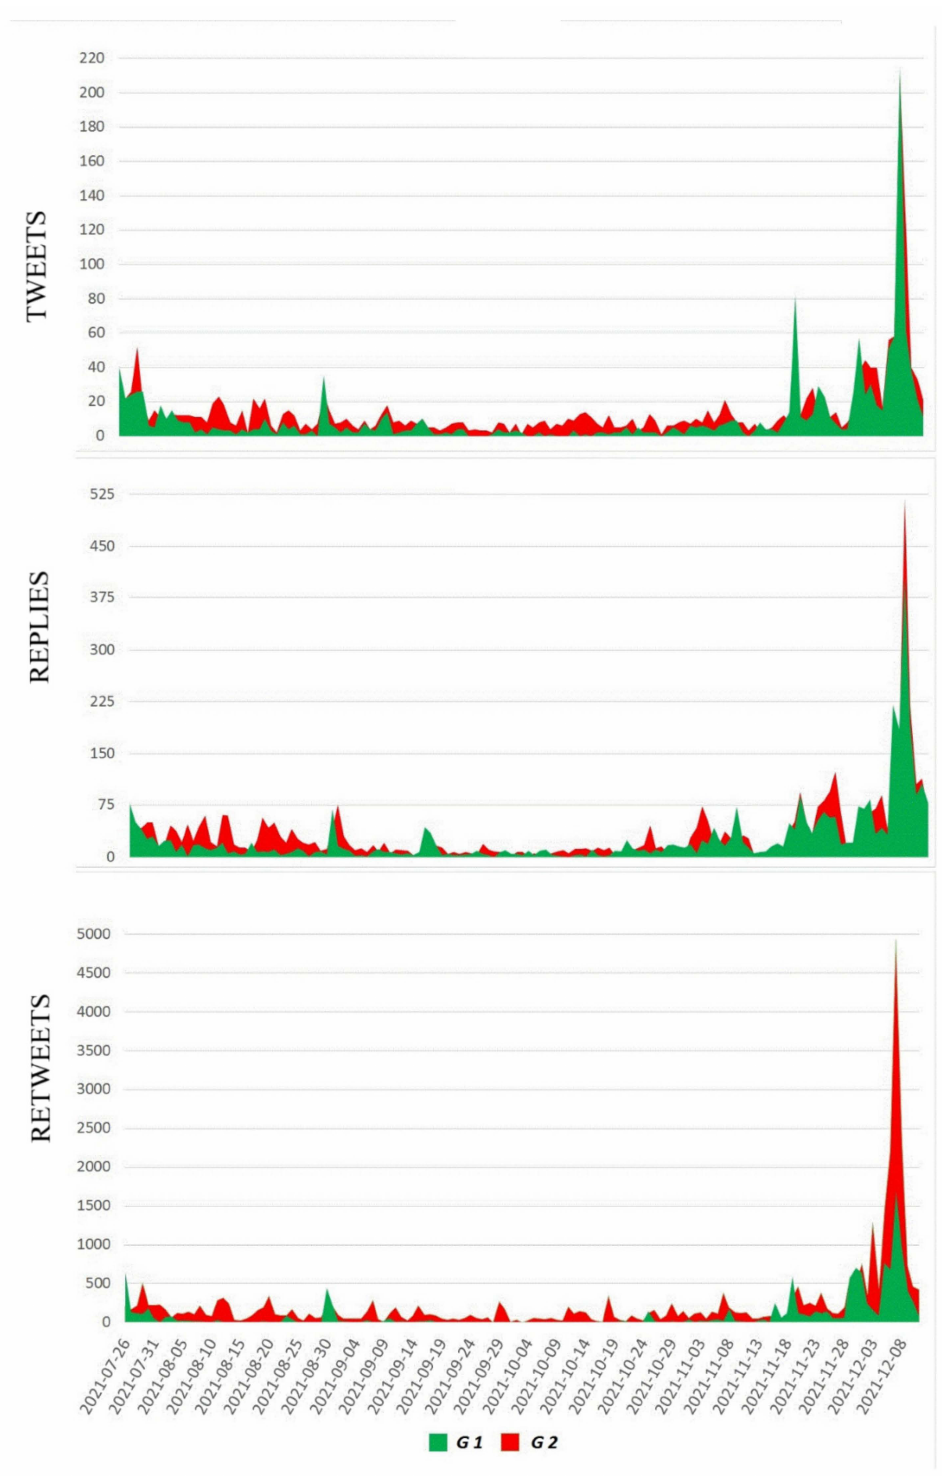
Figure 3. The number of tweets, replies, and retweets published daily by the members of the G1 and G2 groups. As for tweets and replies, both groups showed similar activity, whereas, when it comes to retweets, the G2 group (opponents) was more